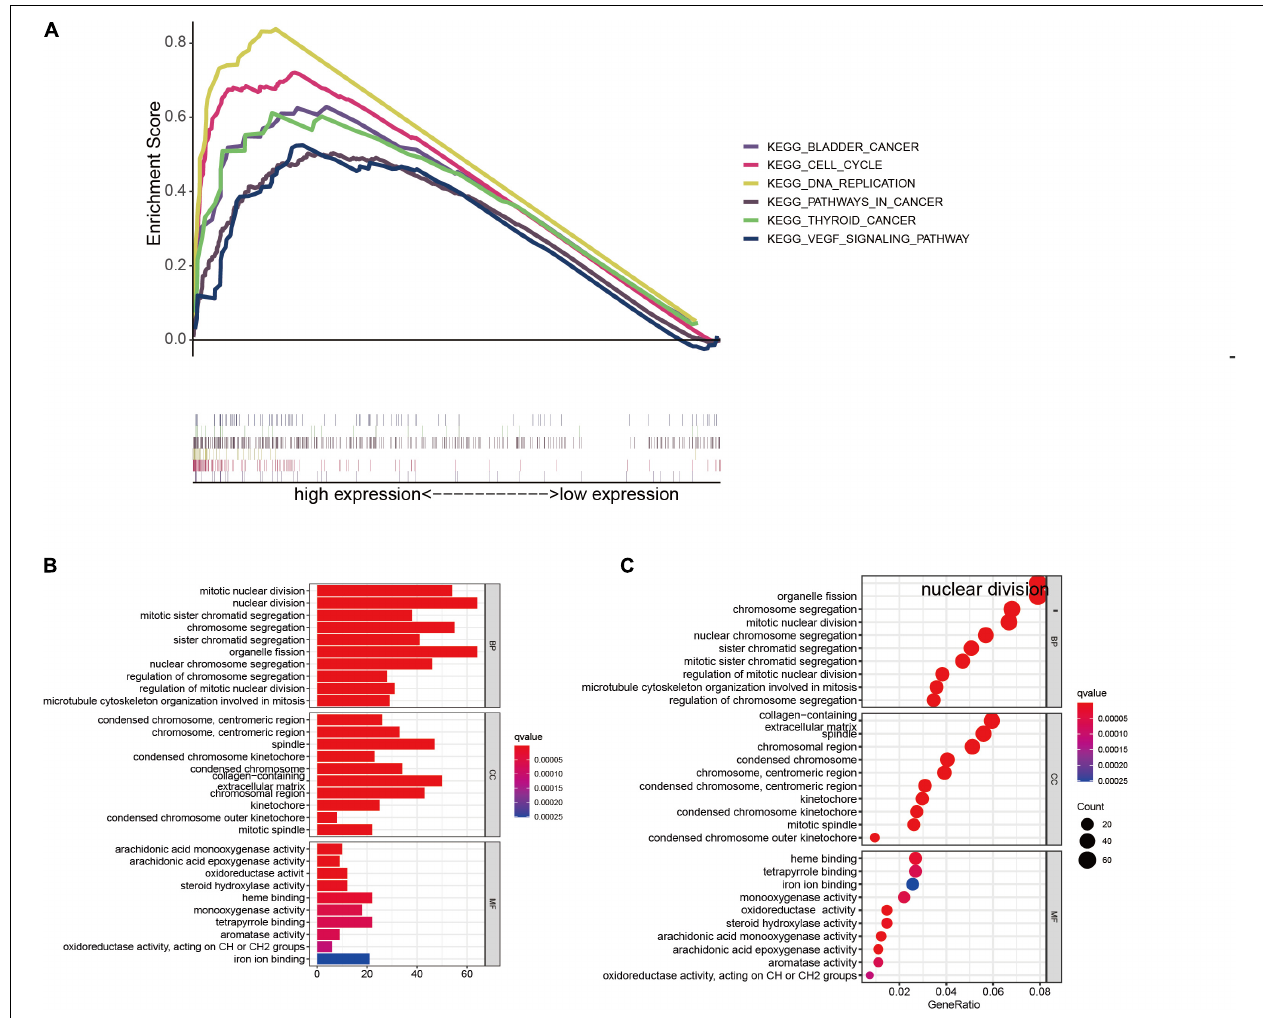
FIGURE 7 | Functional analysis between the low- and high-risk group in the entire cohort. (A) GSEA analysis based on the risk grouping. (B,C) GO analysis between high- and low-risk groups. GSEA, gene set enrichment analysis; GO, Gene